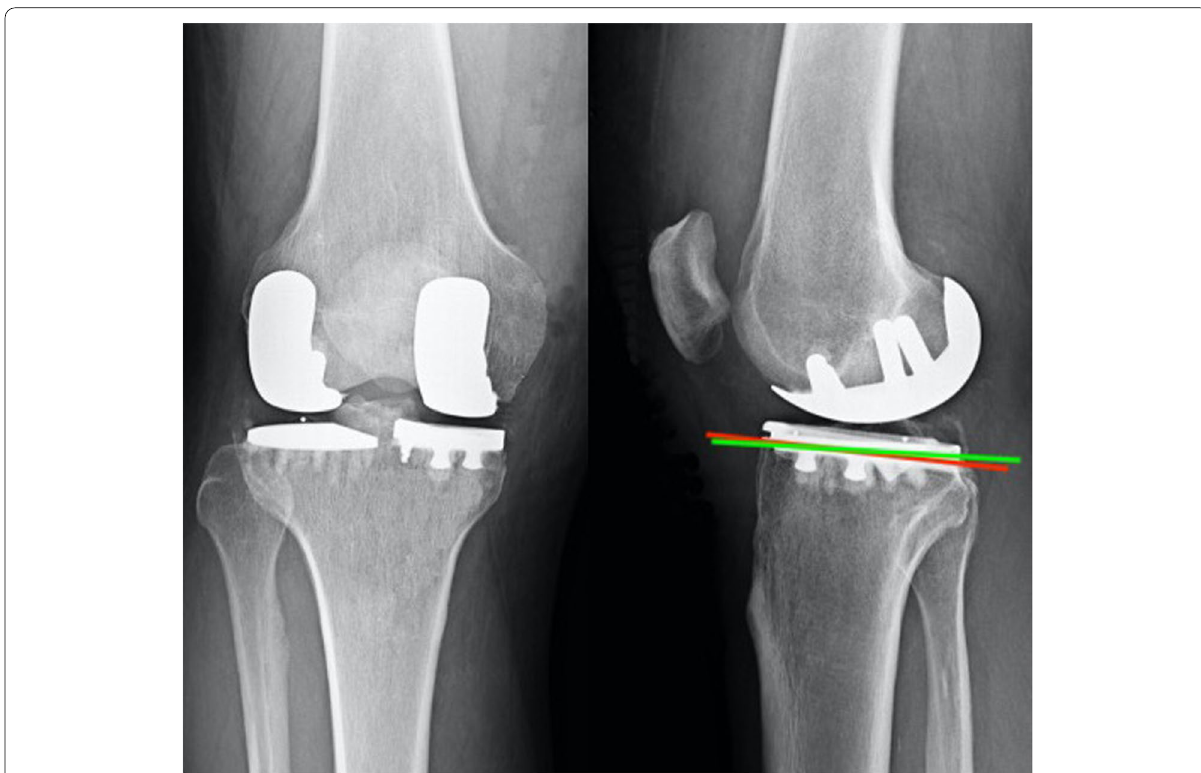
Fig. 4 The medial and lateral compartment have different tibial slope. The medial tibial slope (red line) is steeper than the lateral one (green line)